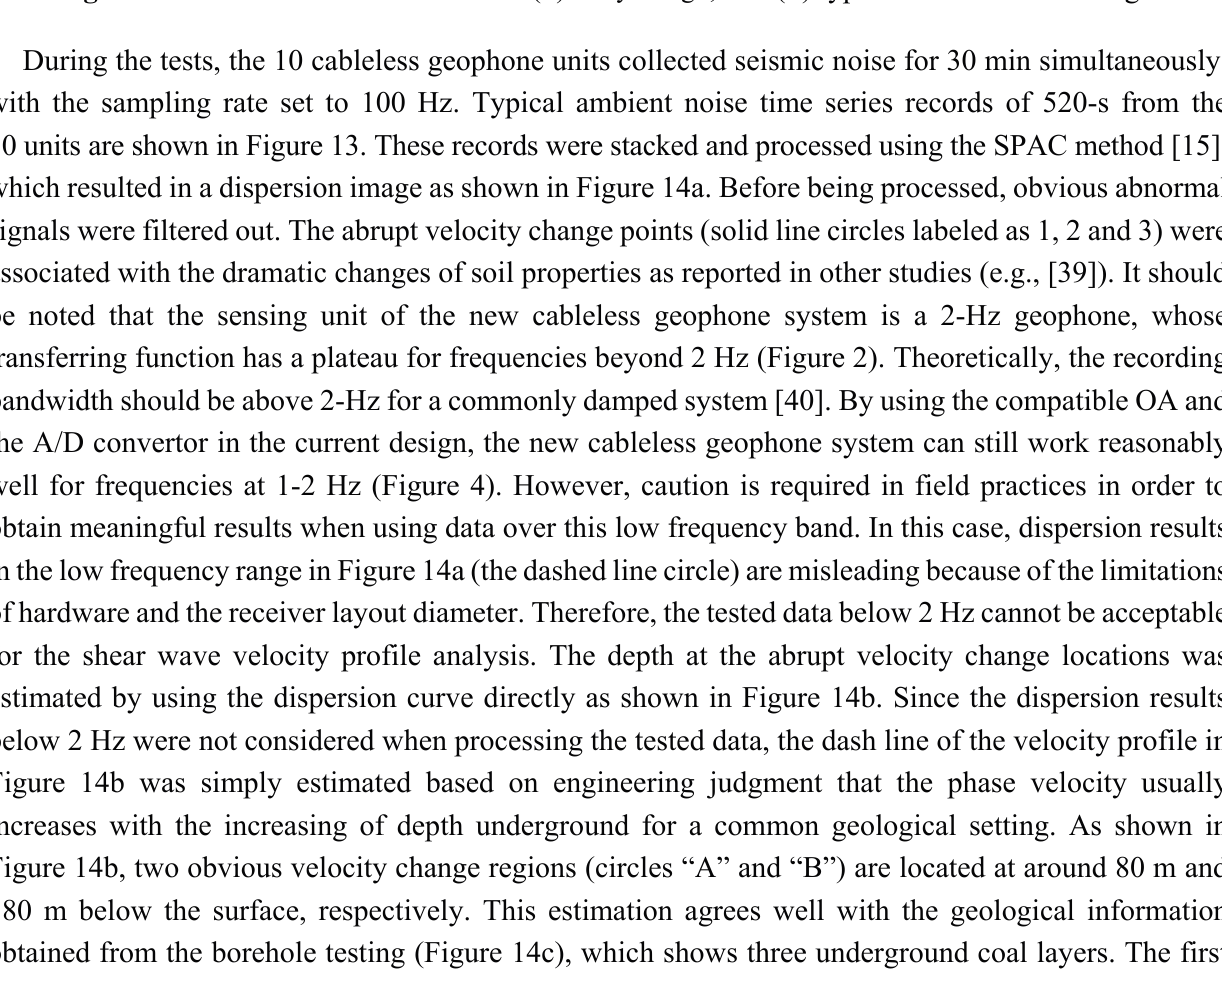
Figure 13. Test at an abandoned mine: ( a ) array design ; and ( b ) typical vibration